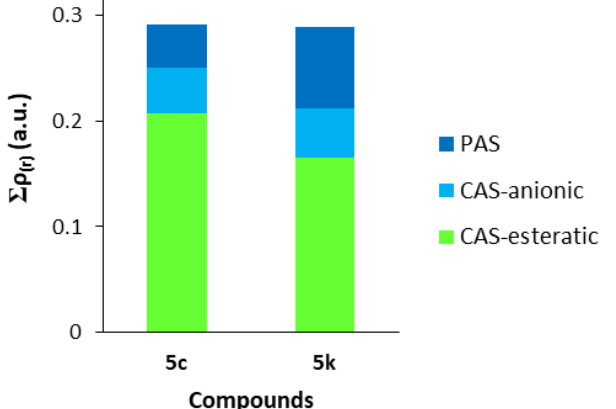
Figure 8. Sum of charge density values at intermolecular bond critical points between BChE and the selected compound. The total height of stacked bars indicates the overall anchoring strength of compounds within the active site. The CAS is devided into the catalytic esteratic subsite (CAS-esteratic) and the catalytic anionic subsite (CAS-anionic).